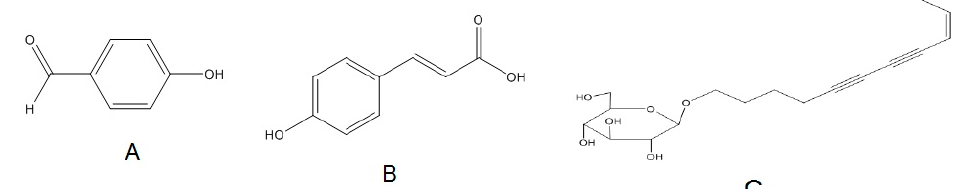
Figure 3. Structures of ( A ) p -hydroxybenzaldehyde; ( B ) p -hydroxy-cinnamic acid; and ( C )